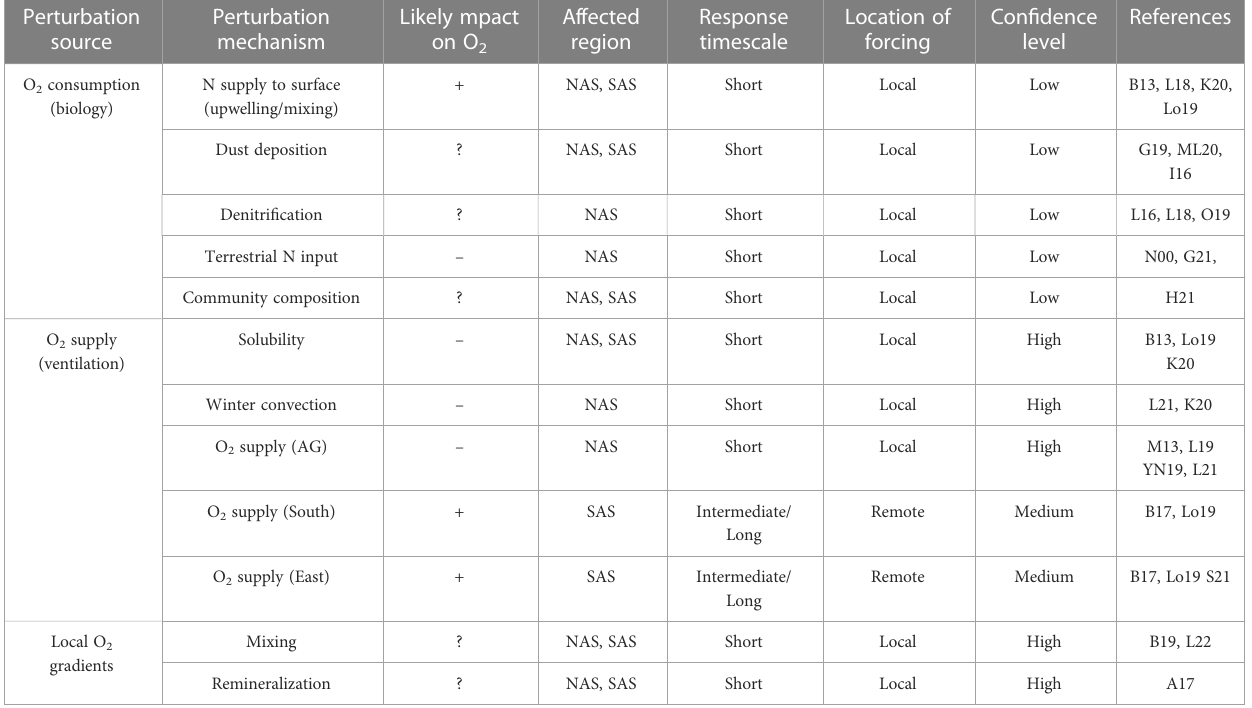
The mechanisms, timescales and uncertainties around potential future O 2 changes in the Arabian Sea region. NAS and SAS refer to the northern (north of 15°N) and southern (south of 15°N) ArabianSea,respectively. Perturbationsexpected tomorelikely increase(decrease) O2are labelledwith+(-)symbols. Poorlyknownprocessesorperturbationswithunclearneteffect onO2are indicatedwith ‘ ? ’ symbol.AbbreviationsusedintheReferences columnare de fi ned asfollows:B13:Bopp etal.(2013),L18:Lachkar etal.(2018),K20:Kwiatkowskiet al.(2020),Lo19:Longetal. (2019)),G19:Guieuetal.(2019),G21:Guptaetal.(2021),ML20:MoffettandLandry(2020),I16:Itoetal.(2016),H21:Hensonetal.(2021),L16:Lachkaretal.(2016),O19:Oschliesetal.(2019), L21:Lachkaretal.(2021),M13:McCrearyetal.(2013),L19:Lachkaretal.(2019),L21:Lachkaretal.(2021),N00:Naqvietal.(2000),B17:Boppetal.(2017),S21:Schmidtetal.(2021),L22:Le ́ vy et al. (2022), A17: Al Azhar et al. (2016), YN19: Al-Yamani and Naqvi